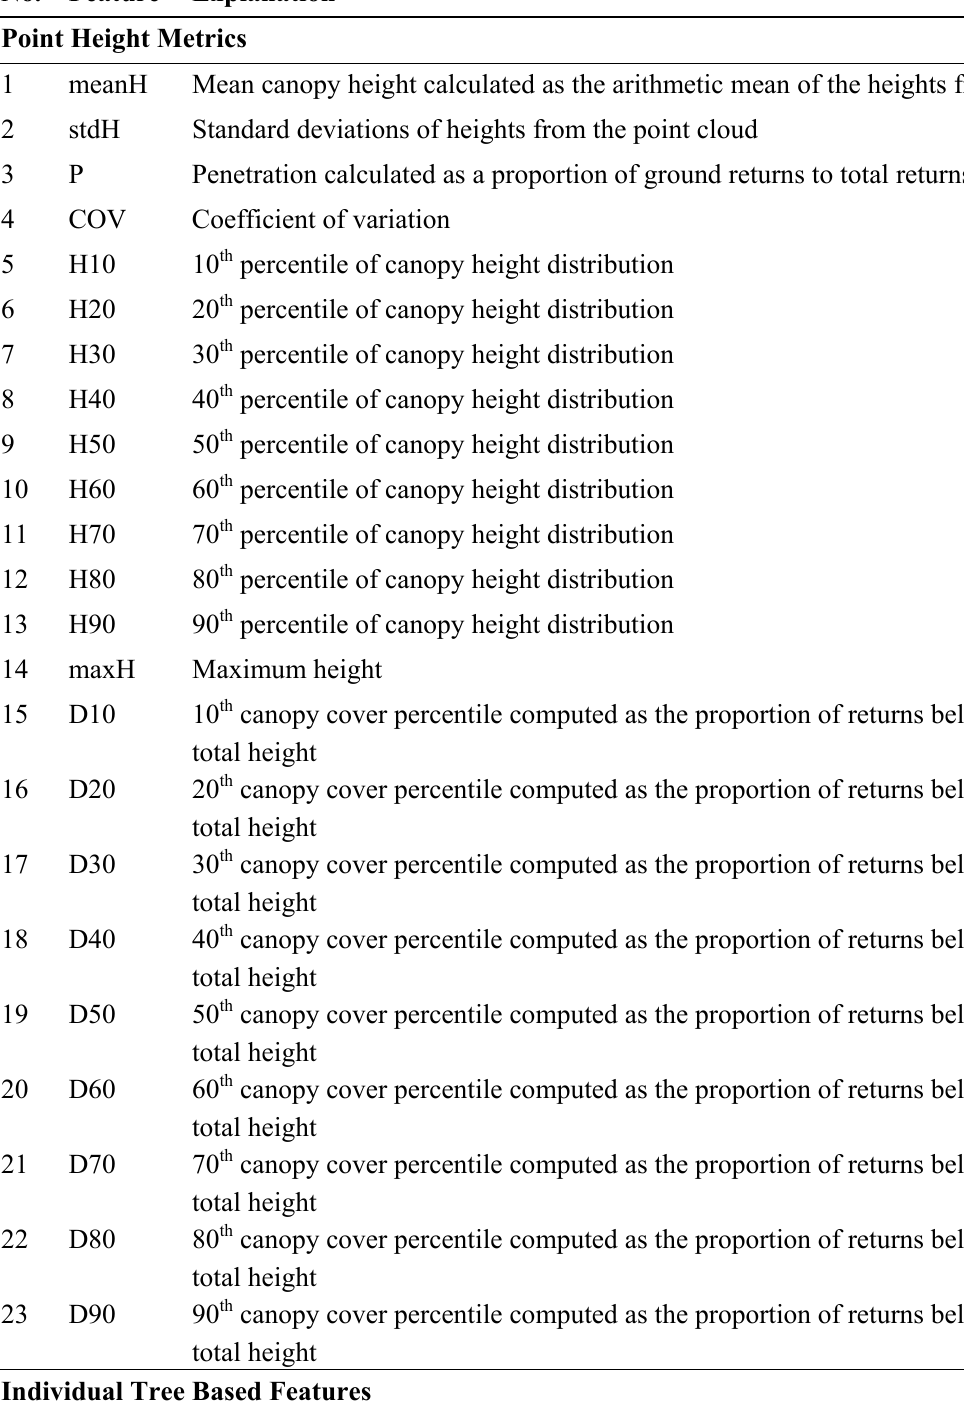
Table 2. The features used in predicting the forest